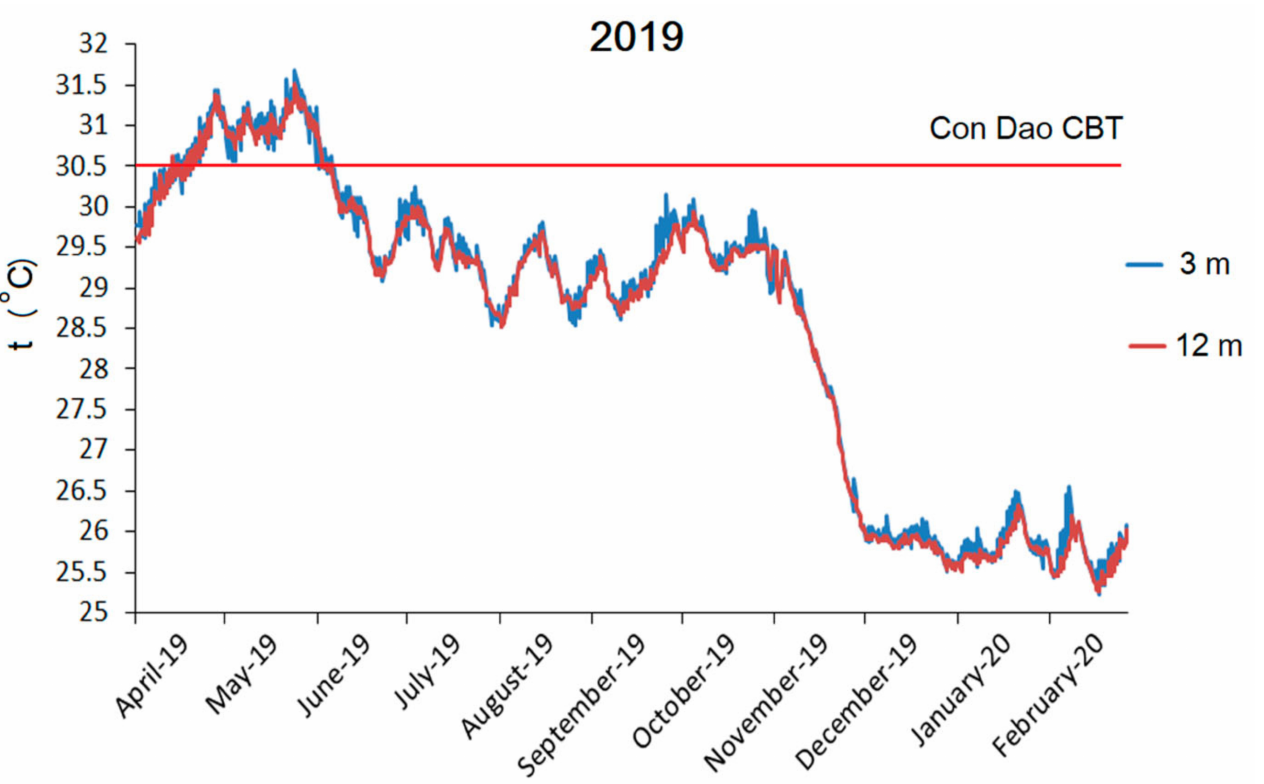
Figure 3. Temperature dynamics over 11 months at 3 m and 12 m of depth obtained by HOBO ® u22-001 temperature loggers. The coral bleaching threshold (CBT) is shown by the red line. The CBT used here is based on NOAA Coral Reef Watch time series data for southern Vietnam and leveled to sea surface temperature (SST) 1 ◦ C higher than the maximum monthly mean SST for this area. The year is pointed out next to the month: 19 mean 2019; 20 mean